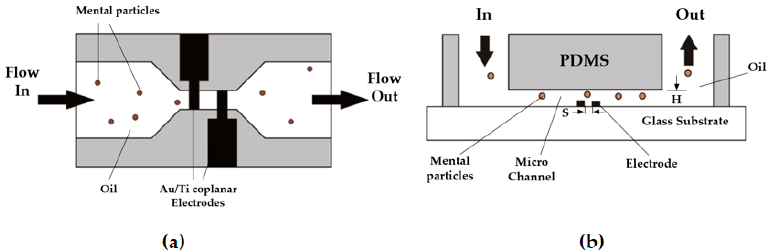
Figure 26. Schematic picture of the microfluidic sensor, ( a ) Top view; ( b ) Front view (Reprinted with permission from Ref. [203]. Copyright IOP Publishing).